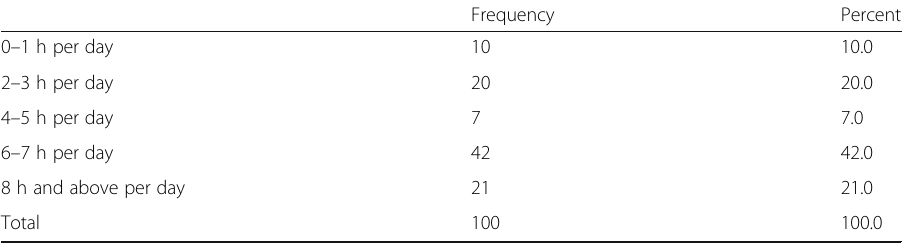
Table 2 Hours Spent on Using Information Systems in Performing